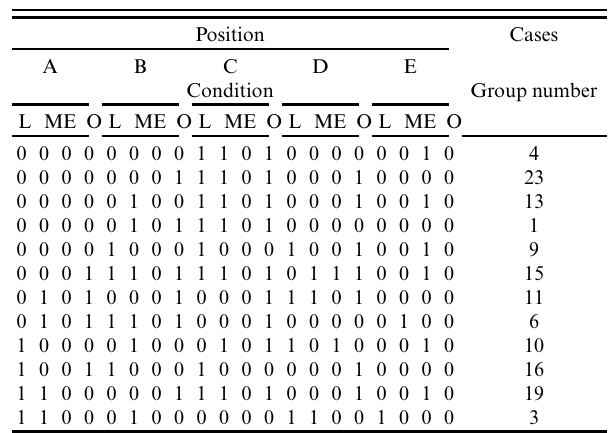
Table 5 . csQCA results of roles by positions (truth table is shown in Appendix